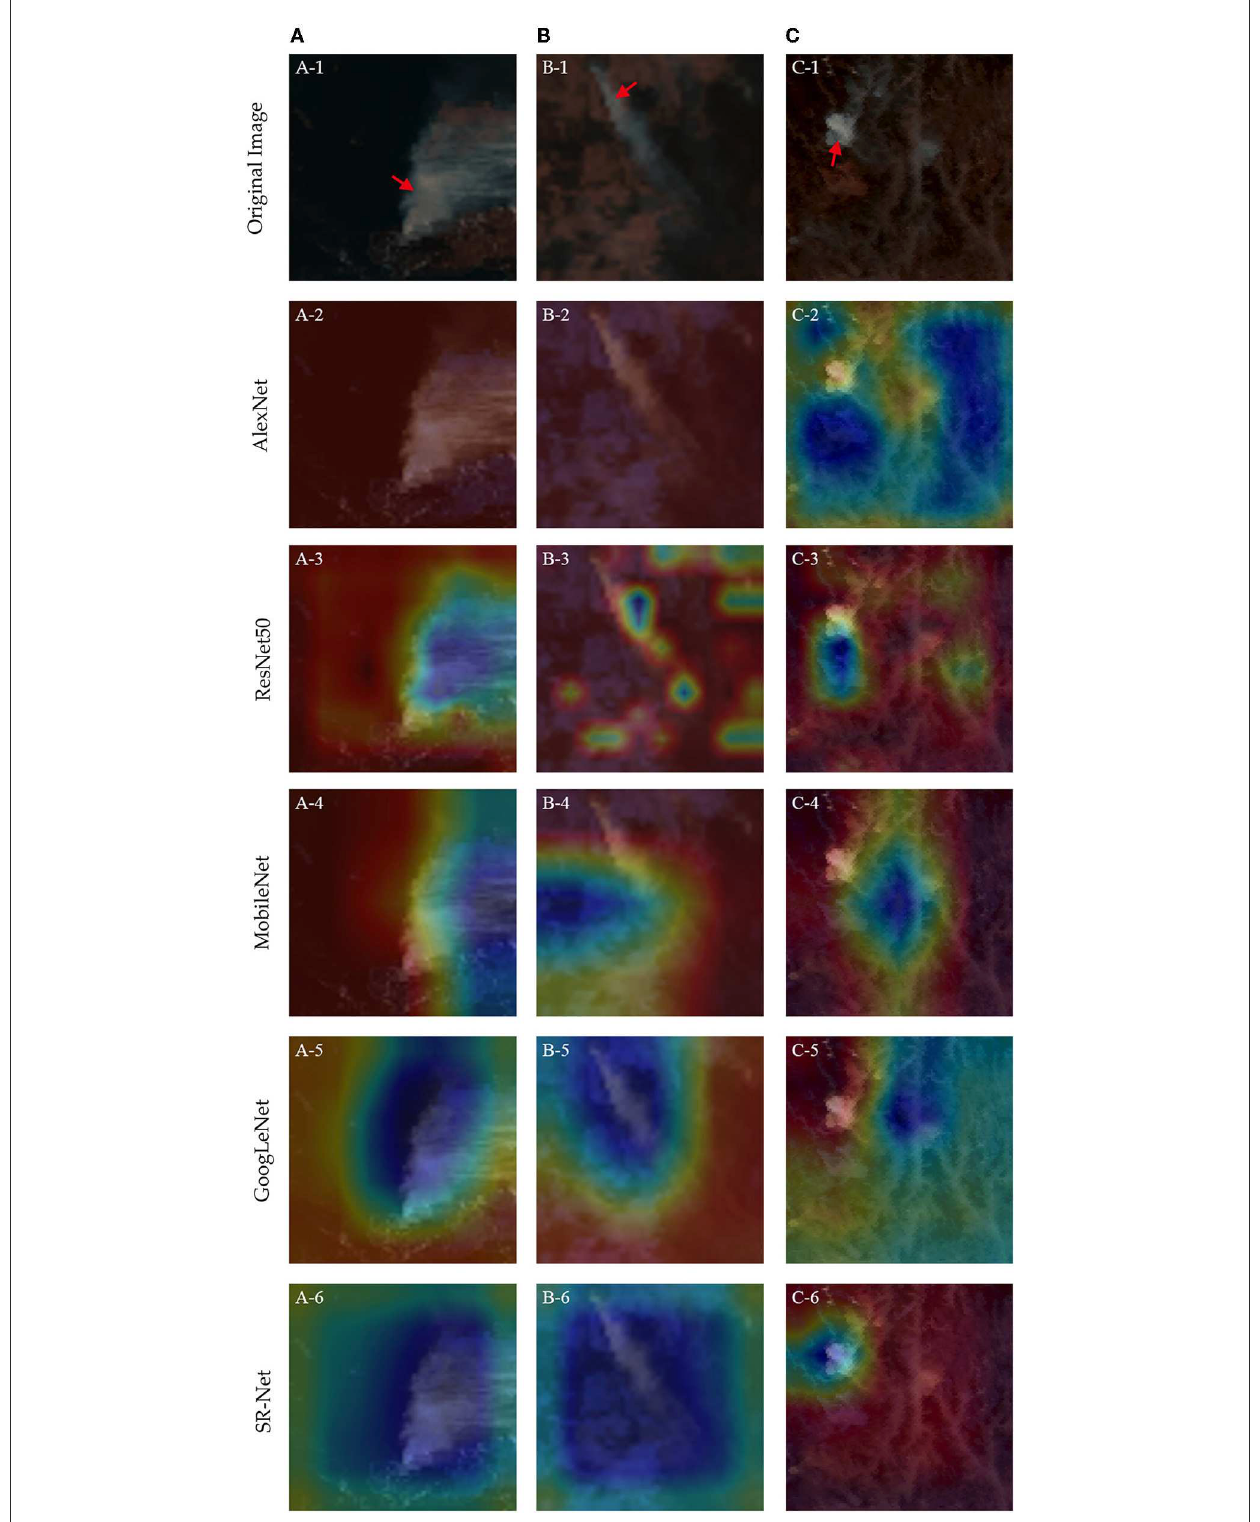
FIGURE7 Original forest fire smoke images (A-1, B-1, C-1), comparison of heat images processed by Grad-CAM based among AlexNet (A-2, B-2, C-2), ResNet50 (A-3, B-3, C-3), MobileNet (A-4, B-4, C-4), GoogLeNet (A-5, B-5, C-5), and SR-Net (A-6, B-6, C-6) models. (A-C) Represents three different sets of forest fire smoke images and heat images based on each model. The attention distribution when the model detects forest fire smoke is marked with blue, yellow, and red in descending order of weight from high to